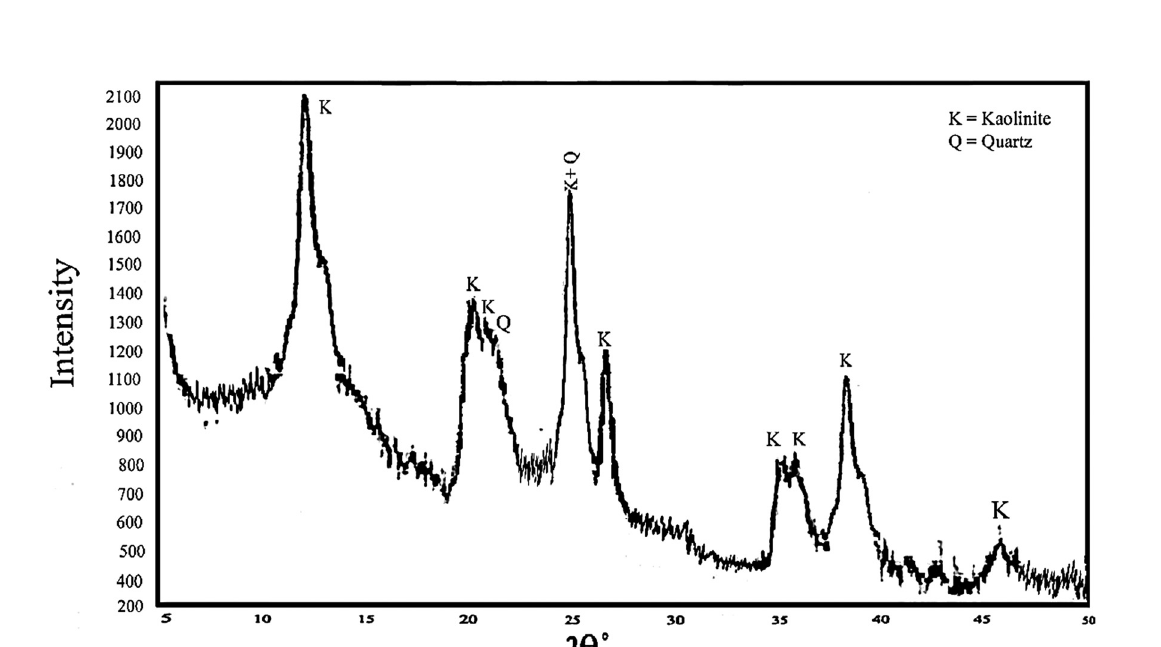
Figure 3: X - Ray di ff raction of kaolin